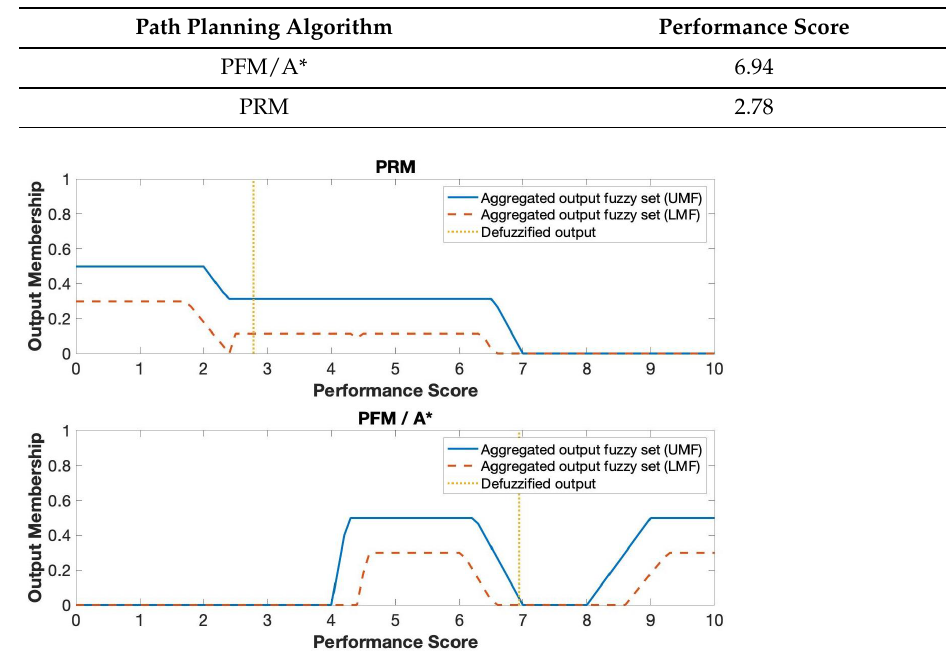
Table 12. Performance Score Output for Case Study III.